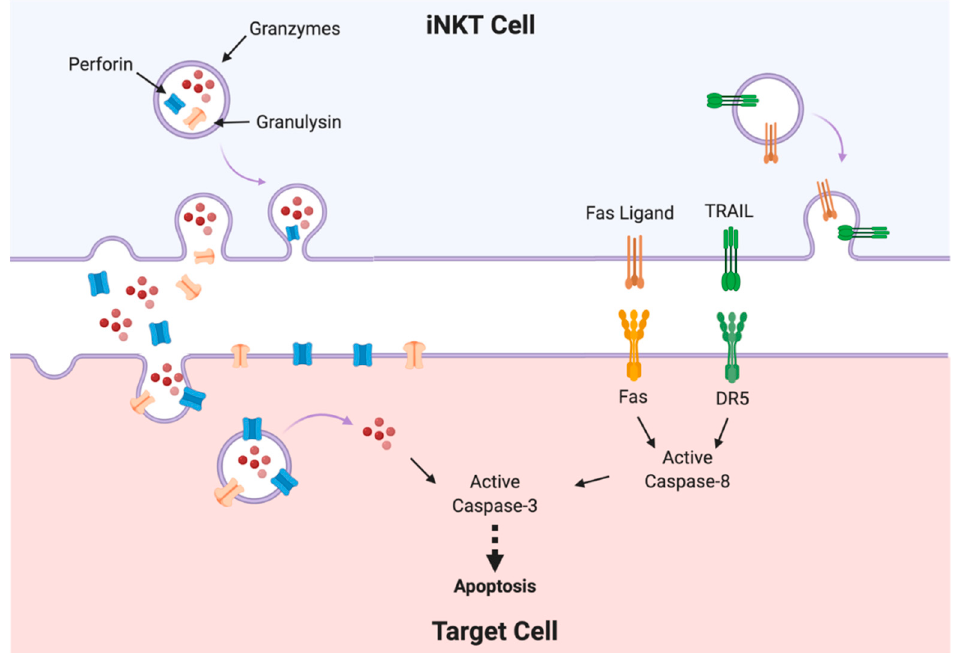
Figure 2. Cytotoxicity mechanisms used by iNKT cells.